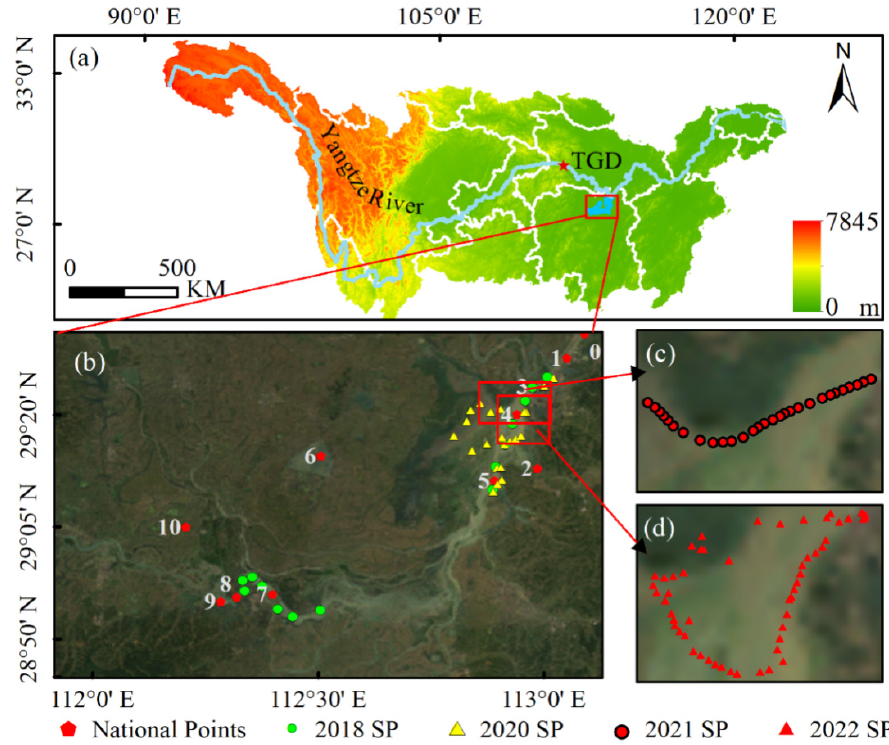
Figure 1. The locations of the Dongting Lake, the Yangtze River, and the TGD ( a ), and the sampling points and the natural color composite in Dongting Lake ( b ); ( c ) and ( d ) are the locations of sampling sites in Dongting Lake in May 2021 and July 2022, respectively.